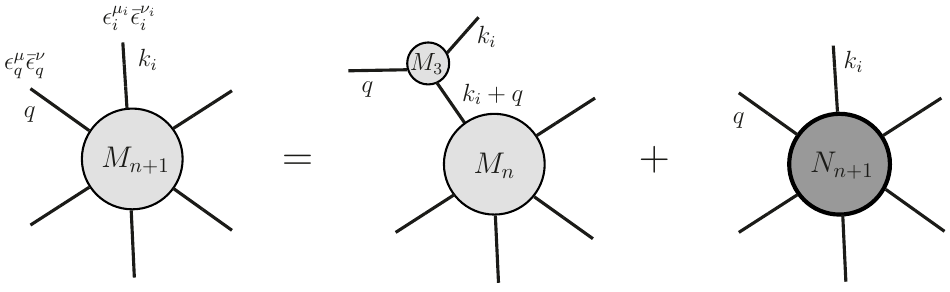
Figure 1 . Decomposition of an n +1-point amplitude into a factorizing set, involving an exchange of a particle between the three-point amplitude M 3 and the n -point amplitude M n , and the reminder set of diagrams N n +1 , which excludes factorization through the former